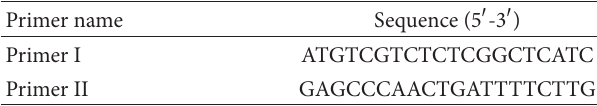
Table 1: PCR and RT-PCR primers for amplifying BcWRKY1